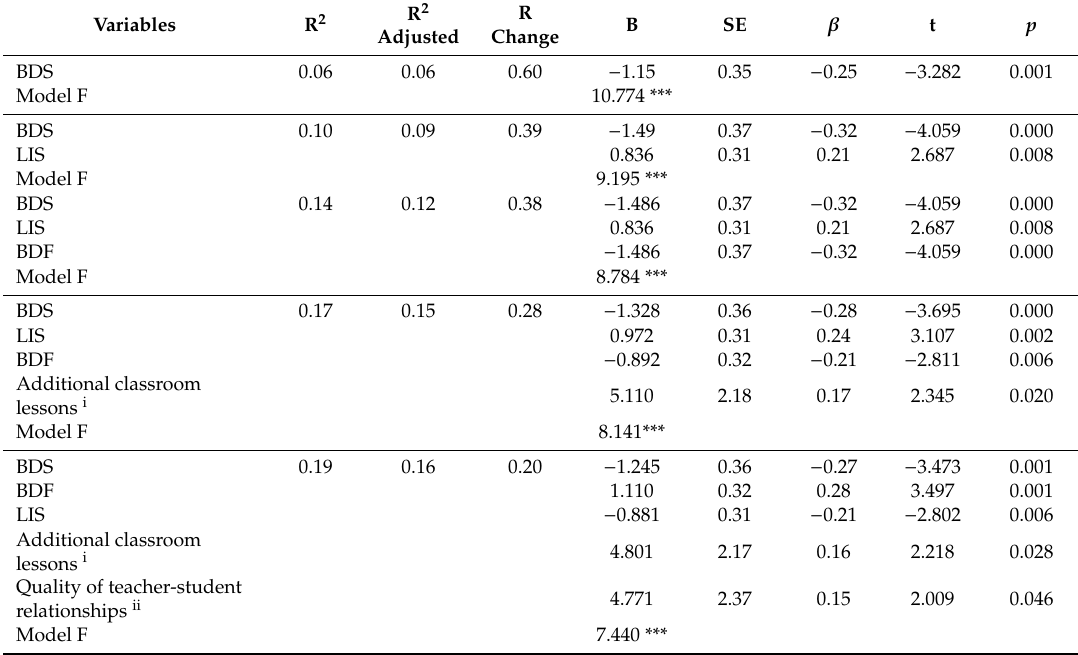
Table 4. Multiple linear regression model of Problematic Internet Use for female group (N = 170).